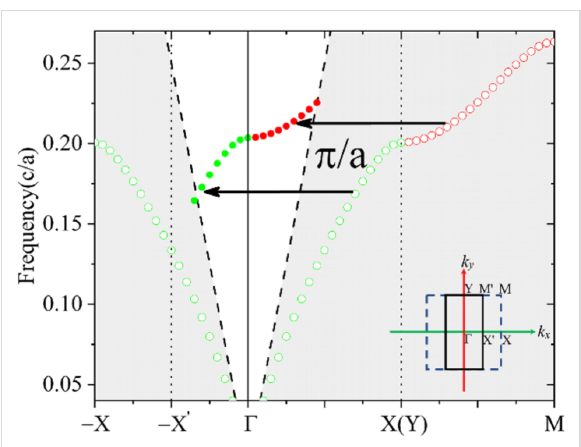
Figure 2: Dispersion curves of the GMs (hollow circles) supported by the PCS of air holes in SOI and the QGMs (solid circles) supported the distorted lattice where the radius of every second column of air holes is changed to R 2 . The inset shows the FBZ for the two cases. The green and red colors denote the dispersion along the k x and k y direction, re-